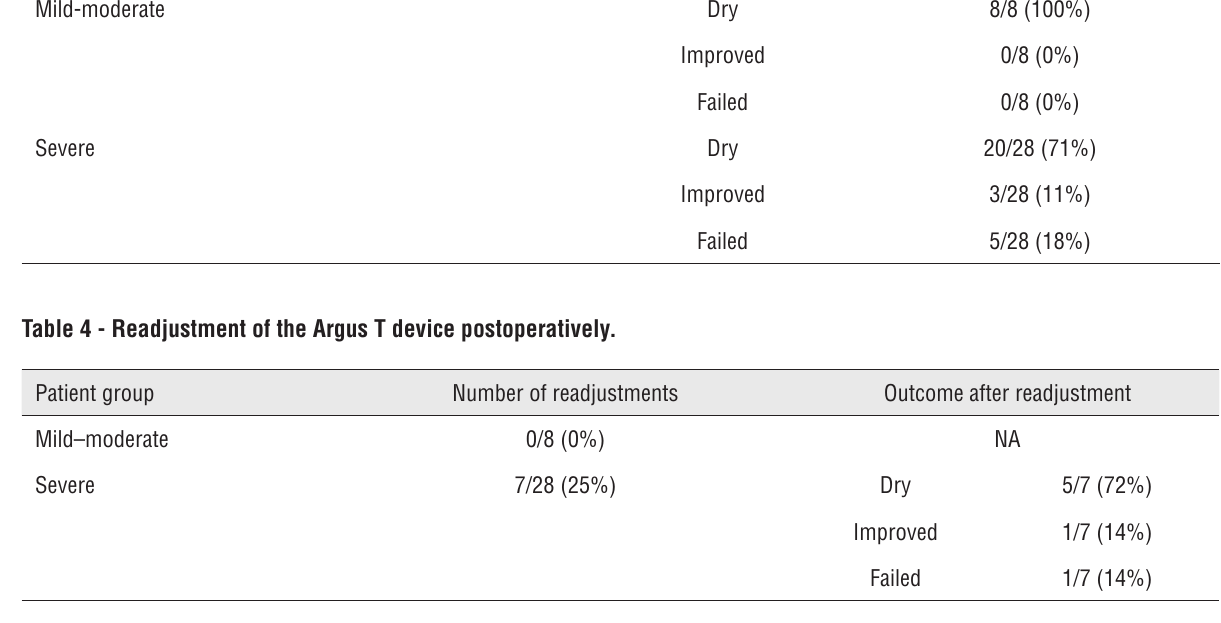
Table 3 - Results segregated by baseline degree of incontinence, according to each patient’s last follow-up. Baseline degree of incontinence